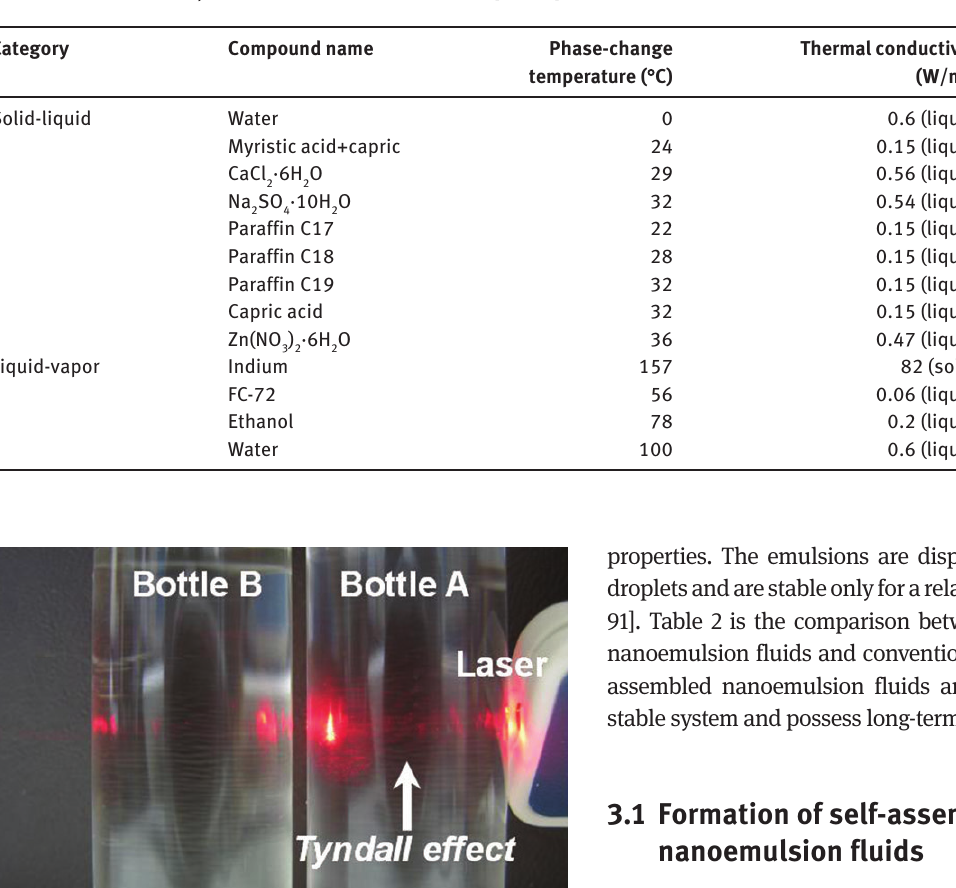
Table 1 The PCMs with potential use in the thermal fluids [66, 67] .